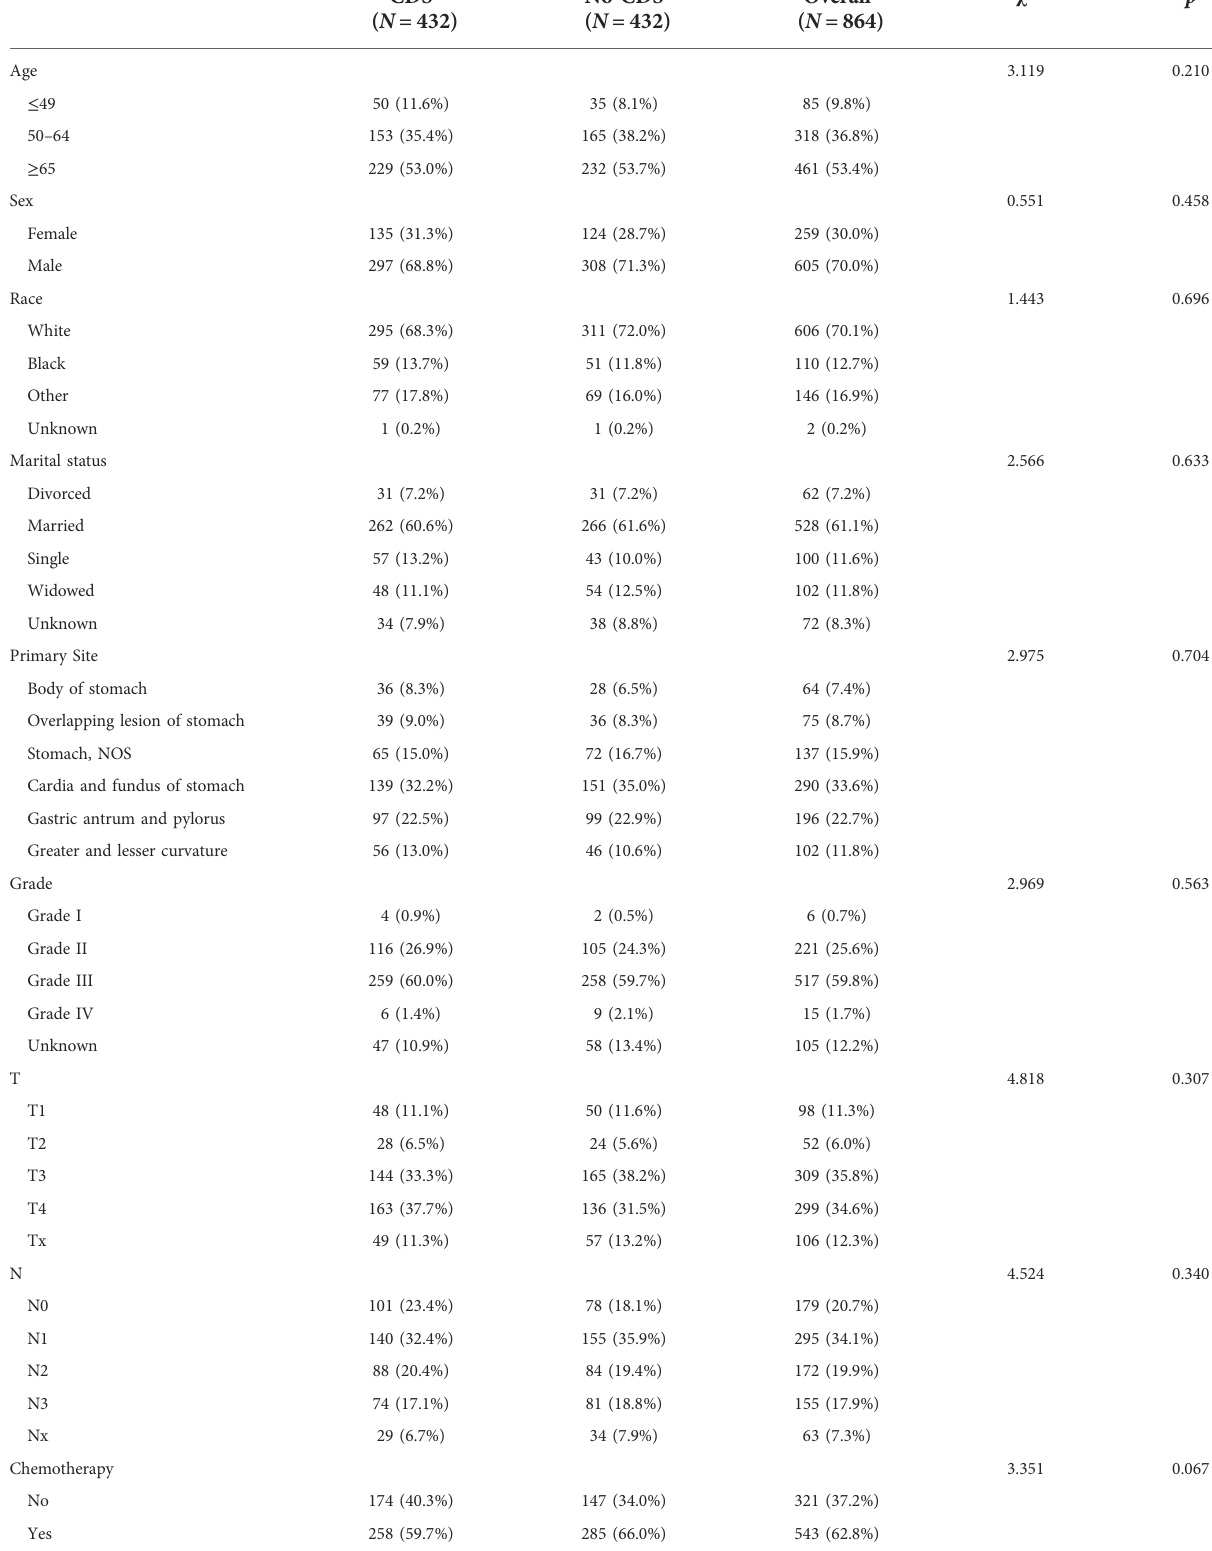
TABLE 2 Baseline characteristics after propensity matching scores, showing statistical comparisons between the CDS and no-CDS